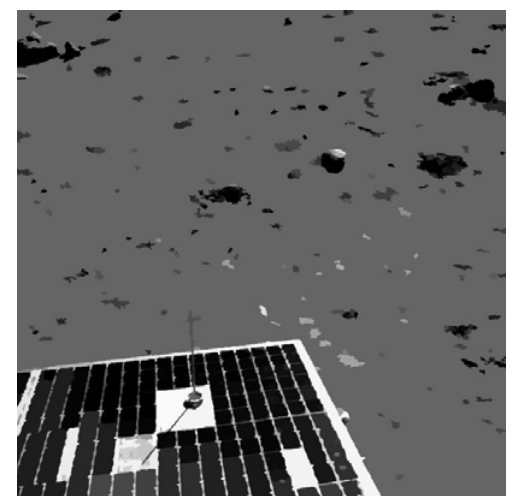
Figure 5. Mean-shift segment result of the left image